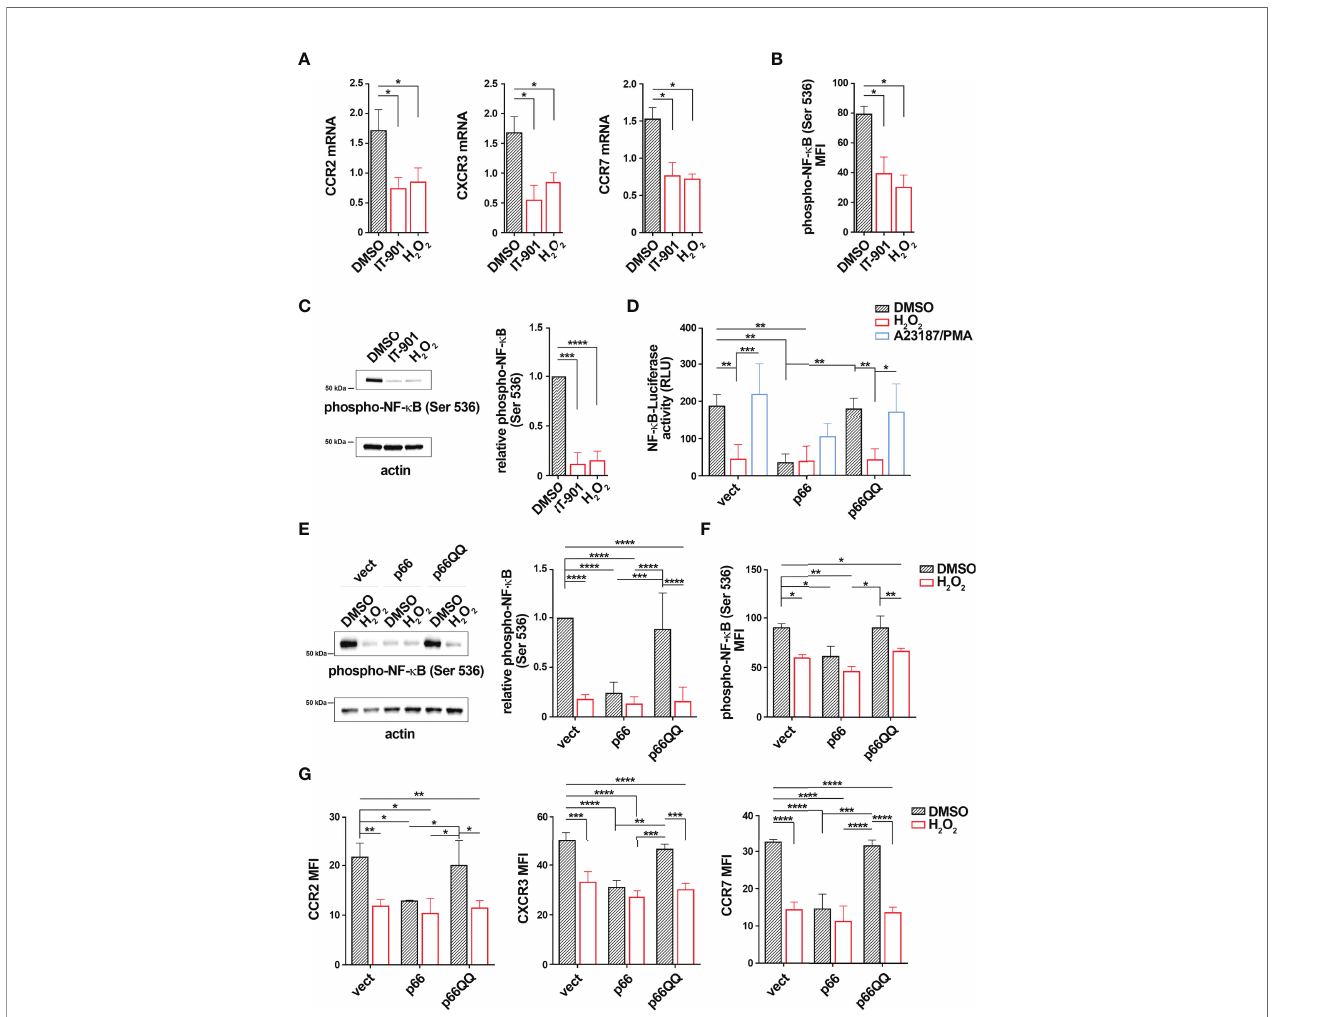
FIGURE 5 | p66Shc normalization inhibits NF- k B activity in CLL cells. (A) Quantitative RT-PCR analysis of CCR2, CXCR3 and CCR7 mRNA in B lymphocytes puri fi ed from peripheral blood of CLL patients (CLL; n CLL patients = 5) treated for 24 h with either 1 m M IT-901 or 100 m M H 2 O 2 . The relative gene transcript abundance was determined on triplicate samples using the ddCt method and normalized to HPRT1. (B, C) Flow cytometric (B) and immunoblot (C) analysis of phospho-NF- k B (Ser536) in B lymphocytes puri fi ed from peripheral blood of CLL patients (CLL) and then treated as above [ (B) n CLL patients = 5; (C) n